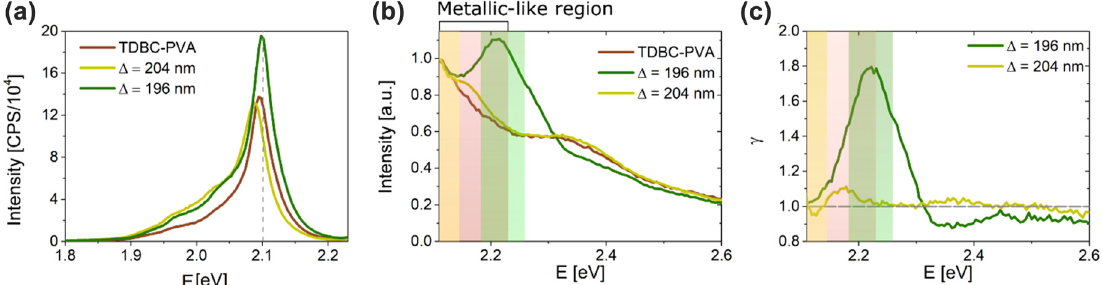
= 2.25 eV of a single exc